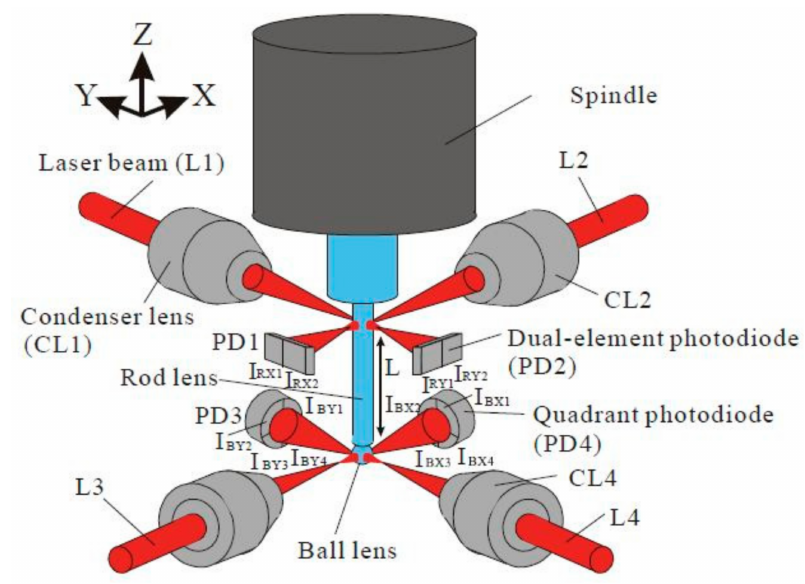
Figure 24. Concept of measurement with a glass pattern